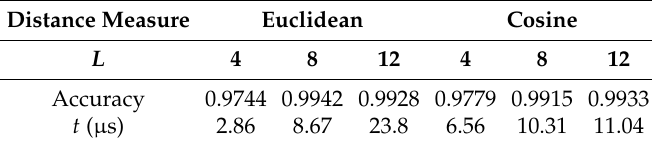
Table 1. Performance of the SOF classifier in different configurations.